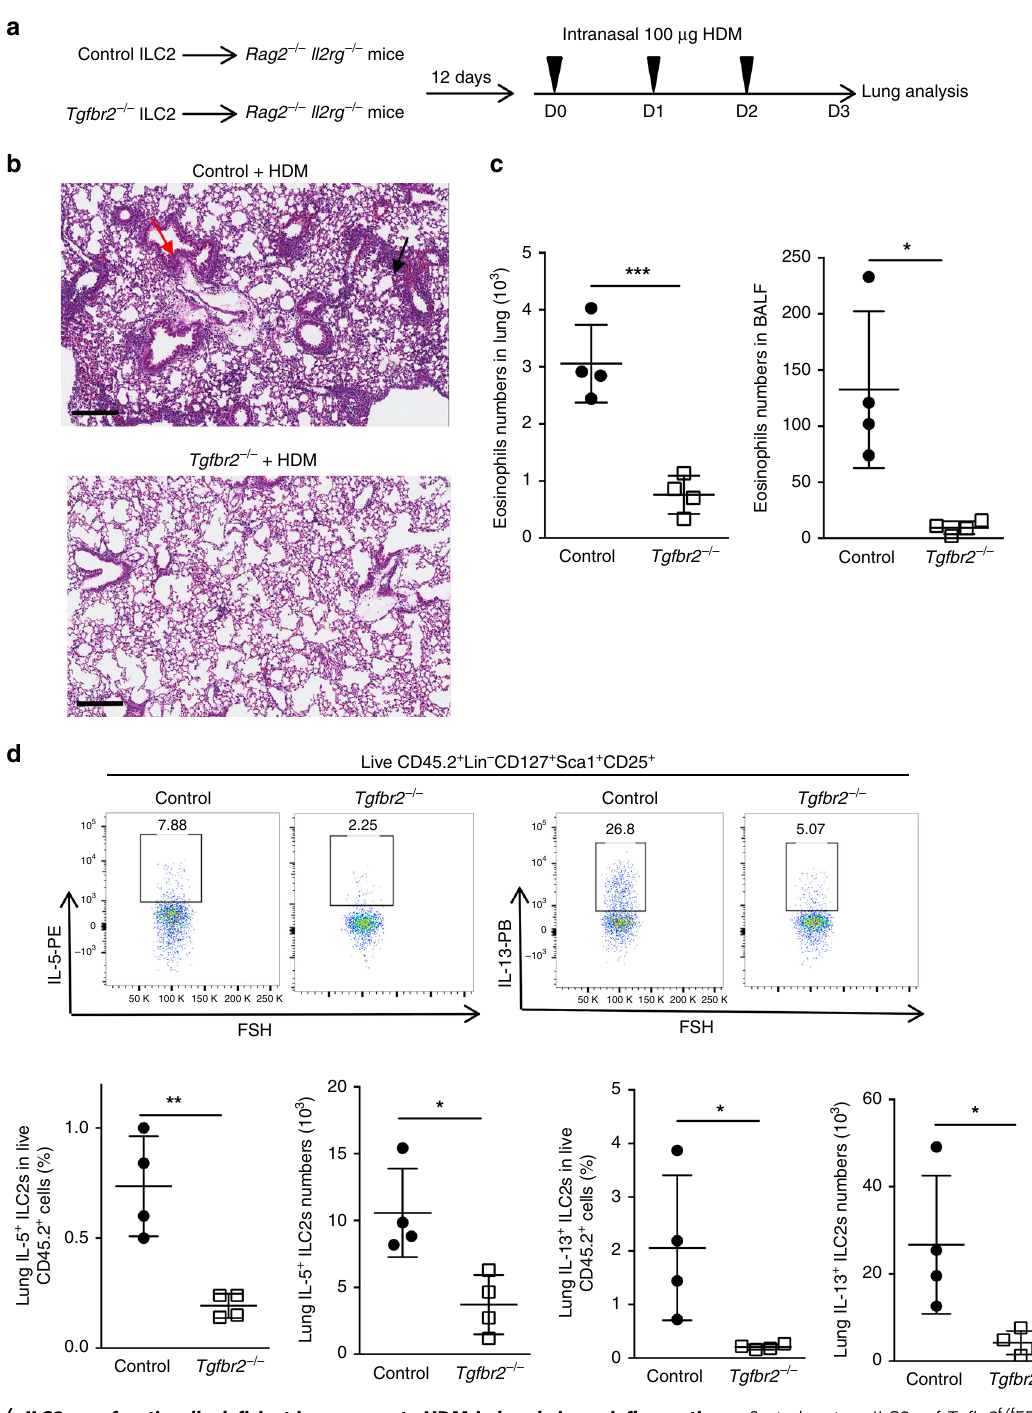
Fig. 7 T β R2 – / – ILC2s are functionally de fi cient in response to HDM-induced airway in fl ammation. a Sorted mature ILC2s of Tgfbr2 f/f ER-Cre + mice pre- treated with tamoxifen ( Tgfbr2 − / − ) or oil (Control) were transferred (5 × 10 5 per mouse) into Rag2 − / − Il2rg − / − mice. Twelve days later, recipient mice were injected intranasally with 100 μ g of HDM in 50 μ l of PBS on days 0 – 2 and further euthanized on day 3. BALF was collected and lungs were dissected for analysis. b In fl ammatory in fi ltrates (black arrows) and mucus secretion (red arrows) were analyzed by H&E staining of formalin- fi xed paraf fi n- embedded lung sections of HDM treated-recipient Rag2 − / − Il2rg − / − mice. Scale bars represent 200 μ m. c The total numbers of eosinophils in the lung and/or BALF of HDM-treated Rag2 − / − Il2rg − / − mice that were transferred with Tgfbr2 − / − ILC2s and Control ILC2s ( n = 4 per group). d Flow cytometry pro fi les and summary of the frequency and total numbers of IL5 + ILC2s, IL-13 + ILC2s gated as CD45.2 + Lin − CD127 + CD25 + Sca1 + in the lung of HDM- treated Rag2 − / − Il2rg − / − mice that were transferred with Tgfbr2 − / − ILC2s and Control ILC2s. Numbers indicate the frequency of fl ow cytometric events ( n = 4 per group). Data are representative of two independent experiments. Data are presented as mean ± SD; * p < 0.05, ** p < 0.01, *** p < 0.001 (Student ’ s t